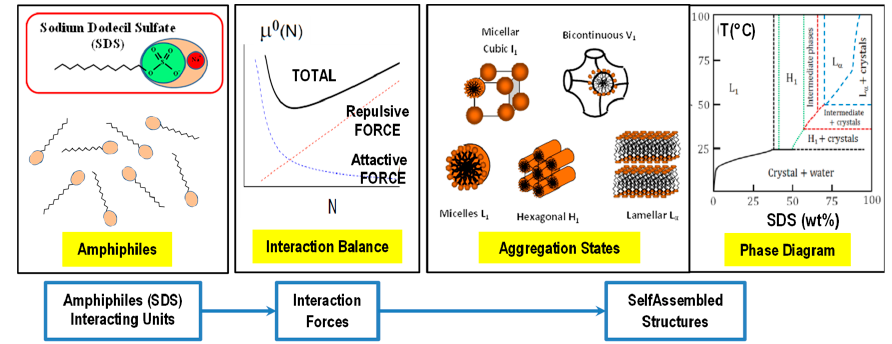
Figure 4. Main features of the self-assembly processes in a water solution of a traditional amphiphile. The phase diagram of the sodium dodecyl sulphate (SDS)/water system is taken from Reference